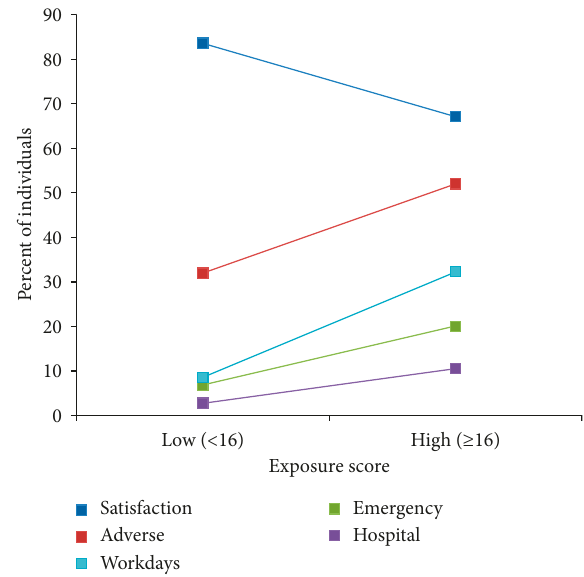
Figure 3: Percent of individuals reporting pain outcomes in the low- or high-exposure score groups. Satisfaction pain management strategies: OR Adverse adverse events from pain management strategies: OR (cid:31) 2.31 (95%